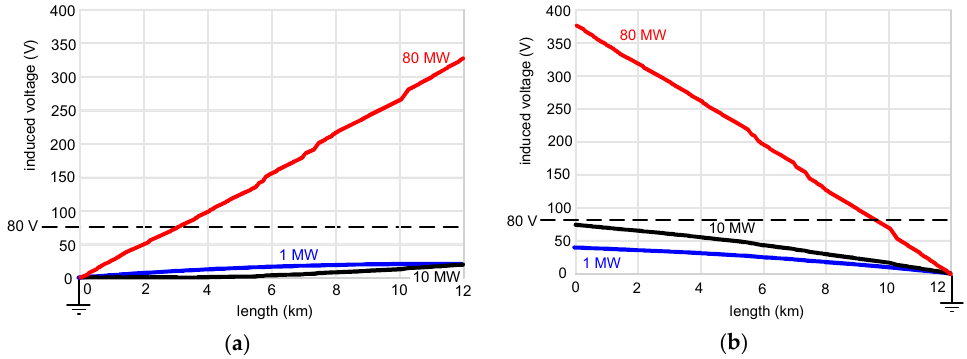
Figure 5. Induced sheath voltages as a function of the cable line length, for three values of the transferred power (1 MW, 10 MW, 80 MW), tg φ = 0: ( a ) single-point bonding at point p.0 in Figure 2; ( b ) single-point bonding at point p.12 in Figure 2.